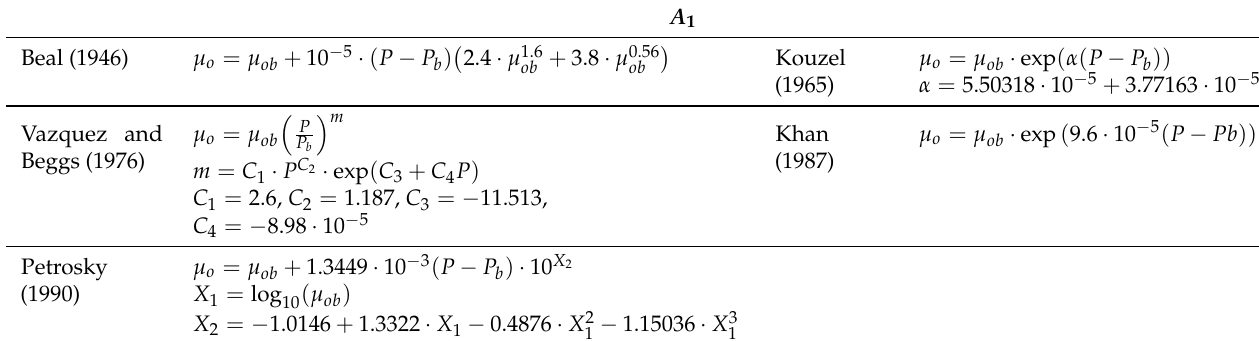
Table 1. Correlations in cluster A 1 .